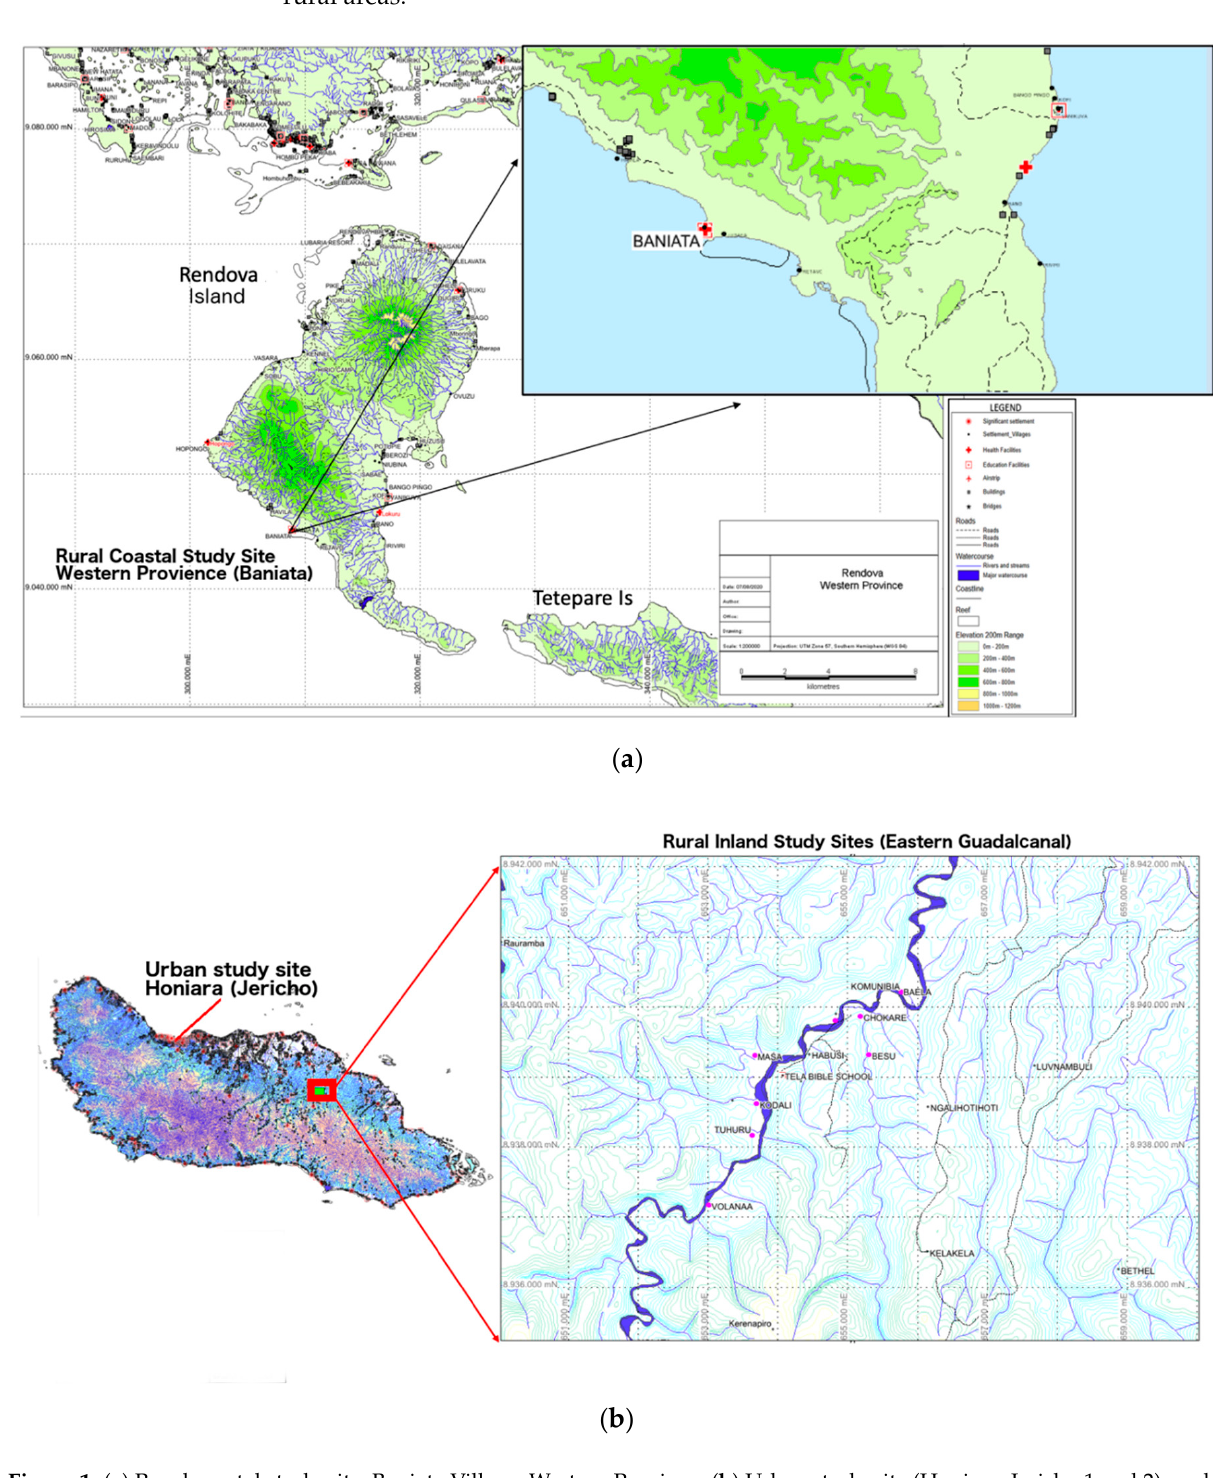
Figure 1. ( a ) Rural coastal study site, Baniata Village, Western Province. ( b ) Urban study site (Honiara, Jericho 1 and 2), and rural inland study sites (Eastern Guadalcanal). ( a , b ) are provided by Carlos Maelaua, a consulting geologist in the Solomon Islands.